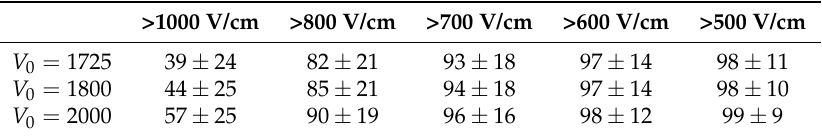
Table 3. Ablation zones percentage. Table shows percentage of tumor above a given electrical field strength from varying σ 0 for tissue.